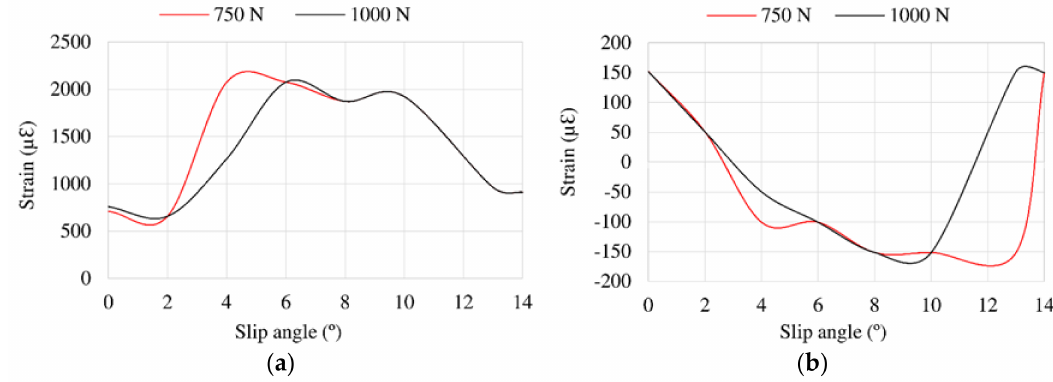
Figure 15. ( a ) Offset values in channel 2 ( ε x ); ( b ) Offset values in channel 3 ( ε y1 ) for different vertical loads at 0.8 bar, 30